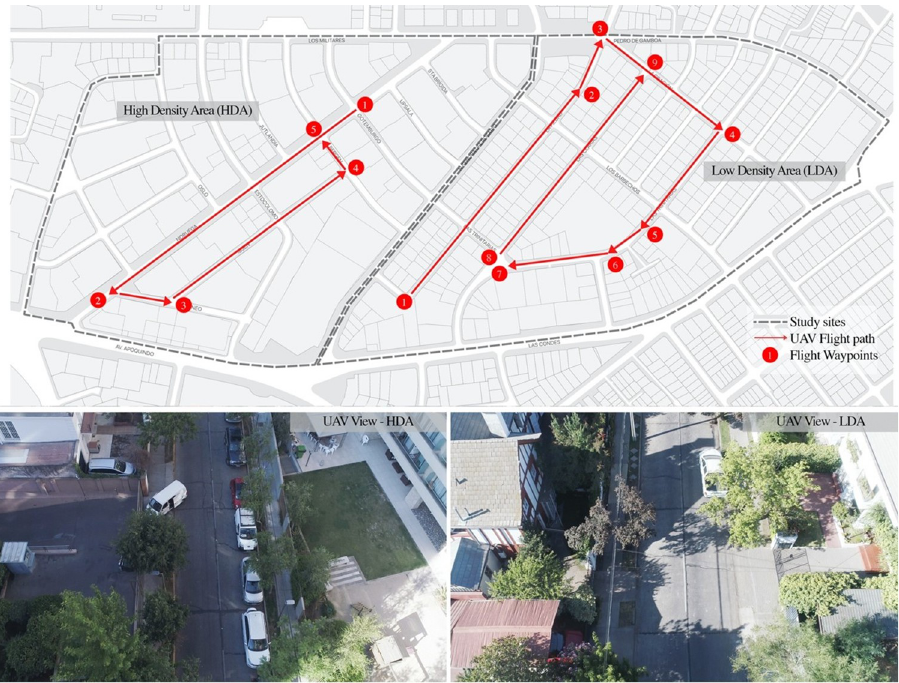
Fig 2. UAV flight path (top) and view from UAV (bottom). Source : own production based on Openstreetmap data and original UAV imagery.